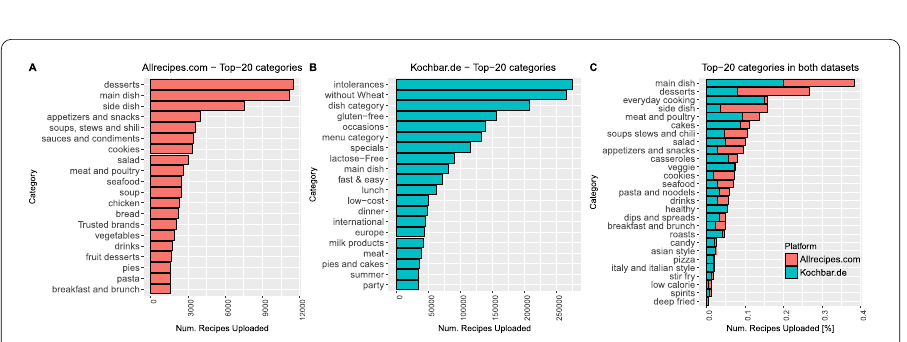
Figure 4 Plot ( A ) and ( B ) show which of the categories in Allrecipes.com and Kochbar.de are the most popular ones (top-20) with respect to number of recipes uploaded to these categories. Plot ( C ) presents which of the categories present in both datasets are the ones with the most recipes uploaded. As presented, the ‘main dish’ category is the largest to which most of the recipes in both platforms are uploaded to